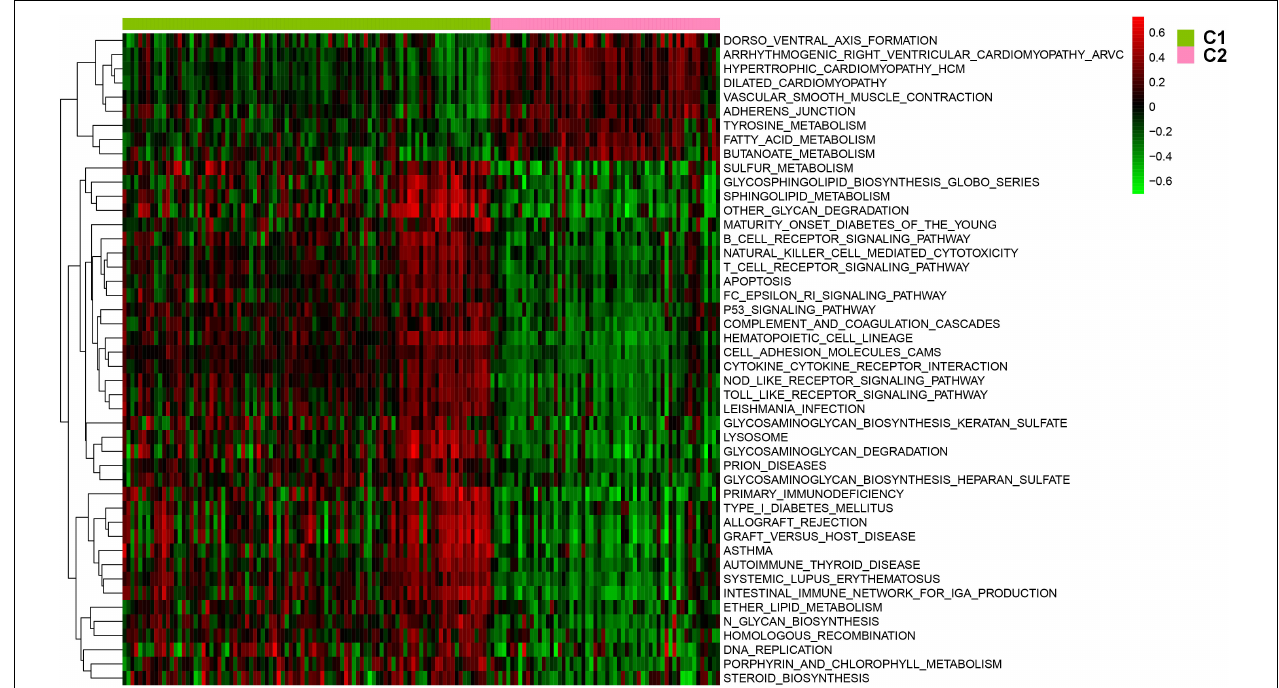
FIGURE 4 | The involved pathway between two distinct subtypes were identified via the Gene Set Variation Analysis (GSVA) analysis.